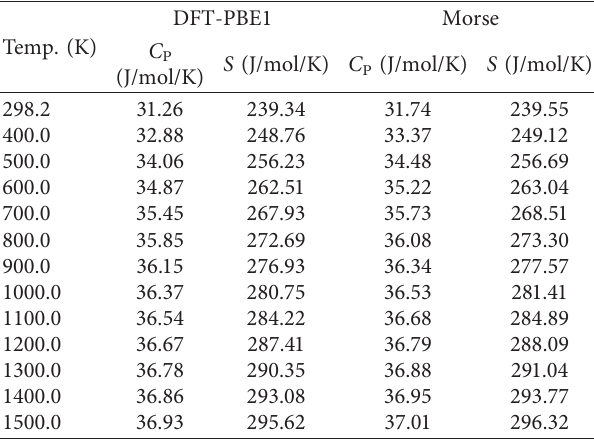
Table 3: Entropy and heat capacity of UN.